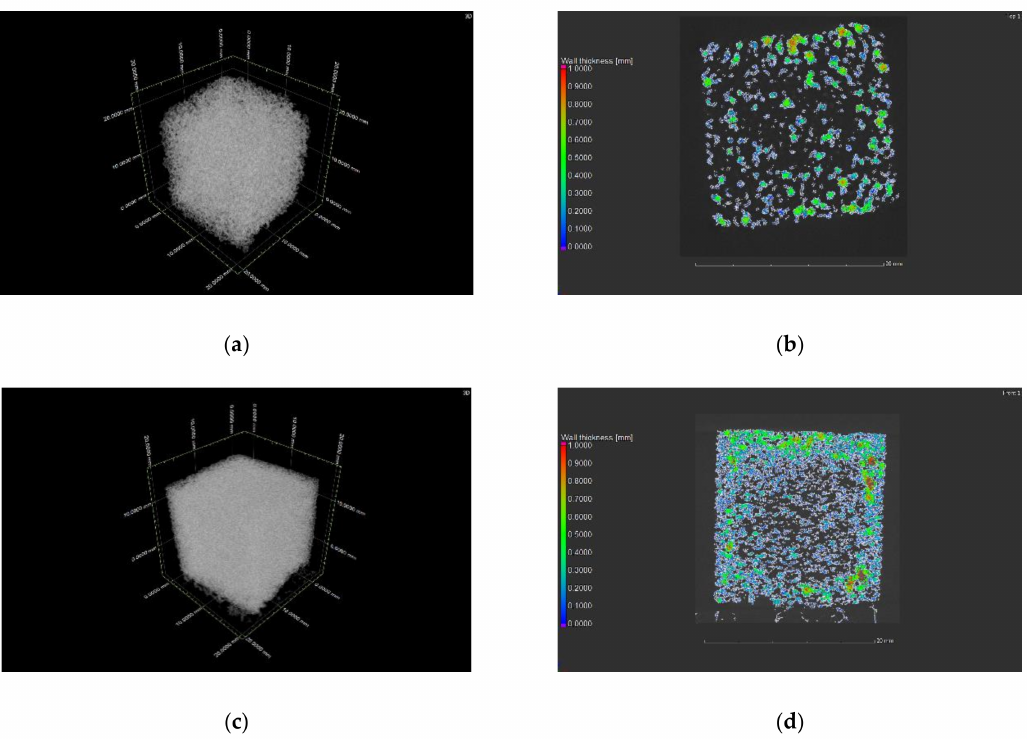
Figure 4. ( a ) 3D microstructure of typical reticulated porous diatomite–kaolin composite with a pore density of 45 PPI, reconstructed by micro-computed tomography (micro-CT). ( b ) Representative slice extracted from the micro-CT reconstructions. ( c ) 3D microstructure of typical reticulated porous diatomite–kaolin composite with a pore density of 80 PPI, reconstructed by micro-CT. ( d ) Representative slice extracted from the micro-CT reconstructions.